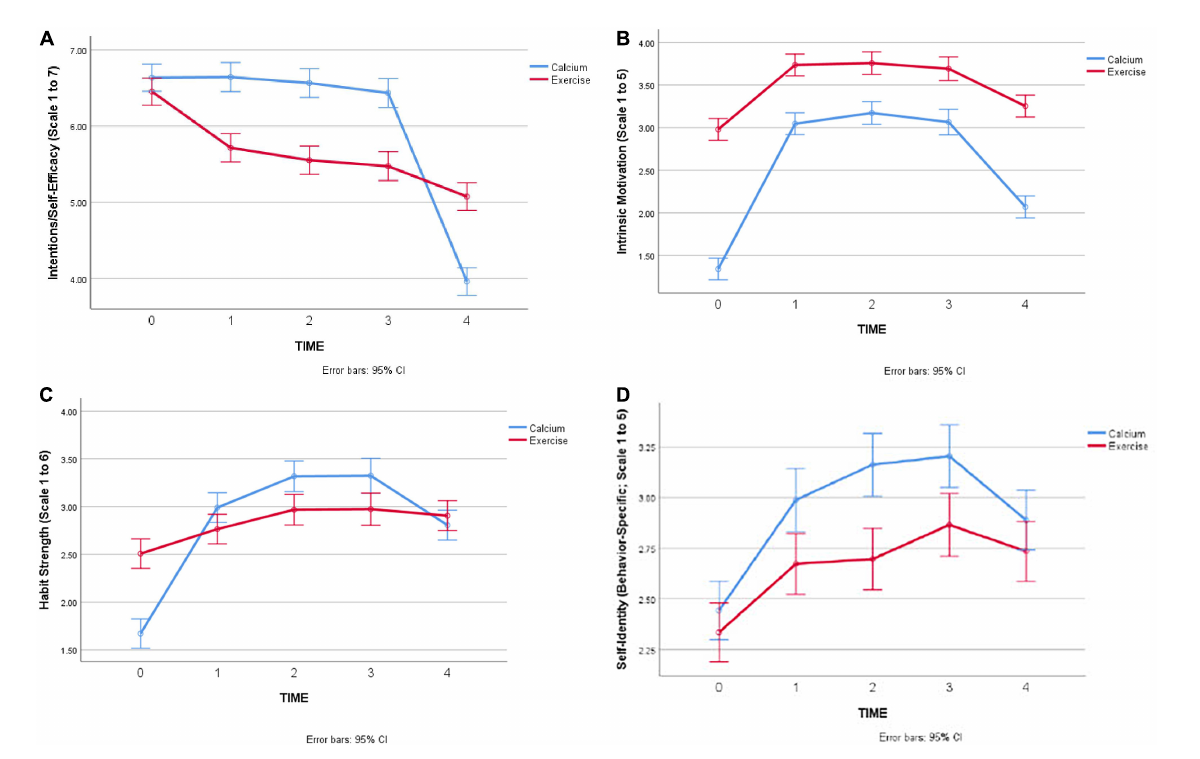
FIGURE1 (A) Change in intentions-efficacy over time, by behavior. (B) Changes in intrinsic motivation over time, by behavior. (C) Changes in habit strength over time, by behavior. (D) Changes in behavioral identity over time, by